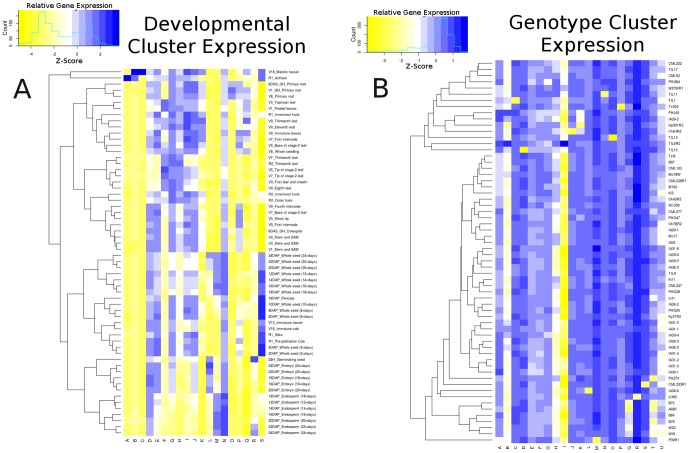
Expression patterns driving co-expression network clusters.Clusters identified in Figure 2 (shown on horizontal axis) were further broken down into raw expression components by sample (shown on vertical axis). Expression patterns for each cluster of highly co-expressed genes are different for each cluster. Raw expression values are normalized compared to global background expression levels of genes within a cluster indicated here with the color white. Blue indicates over expression while yellow indicates under expression of a gene cluster. (A) shows developmental clusters while (B) shows genotype clusters.